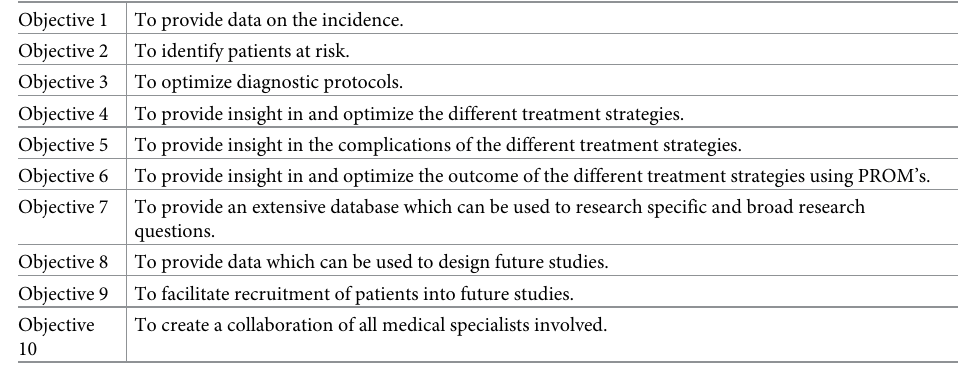
Table 1. Objectives of the TROTS registry with respect to primary upper extremity deep venous